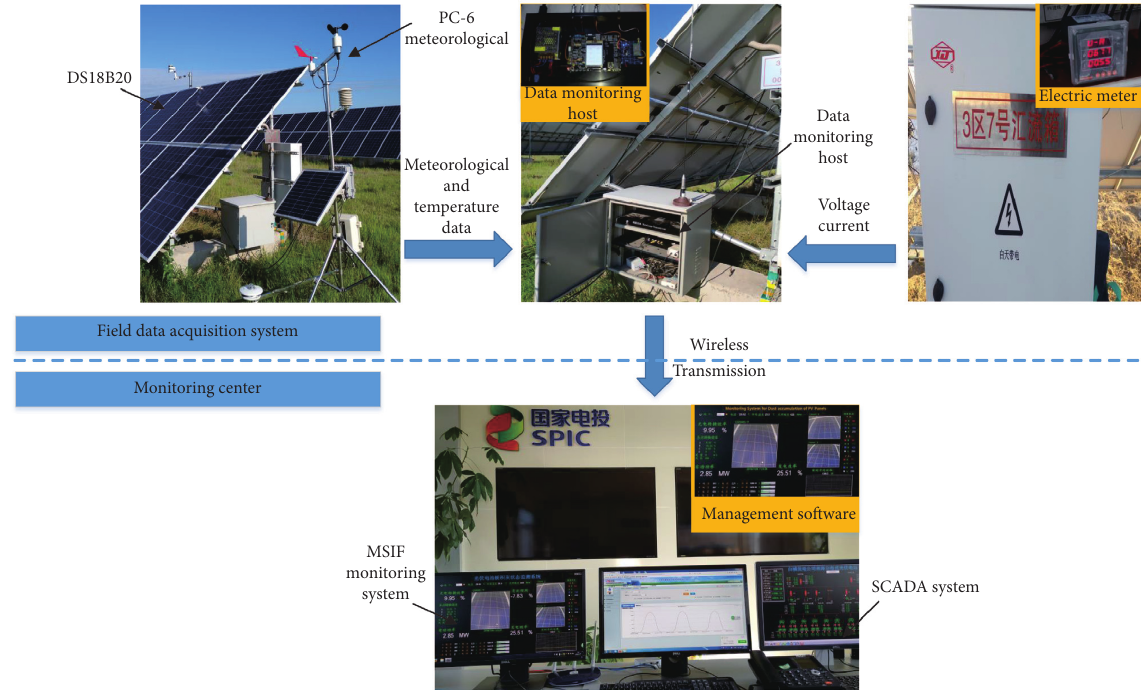
Figure 2: The MSIF monitoring system at the experimental